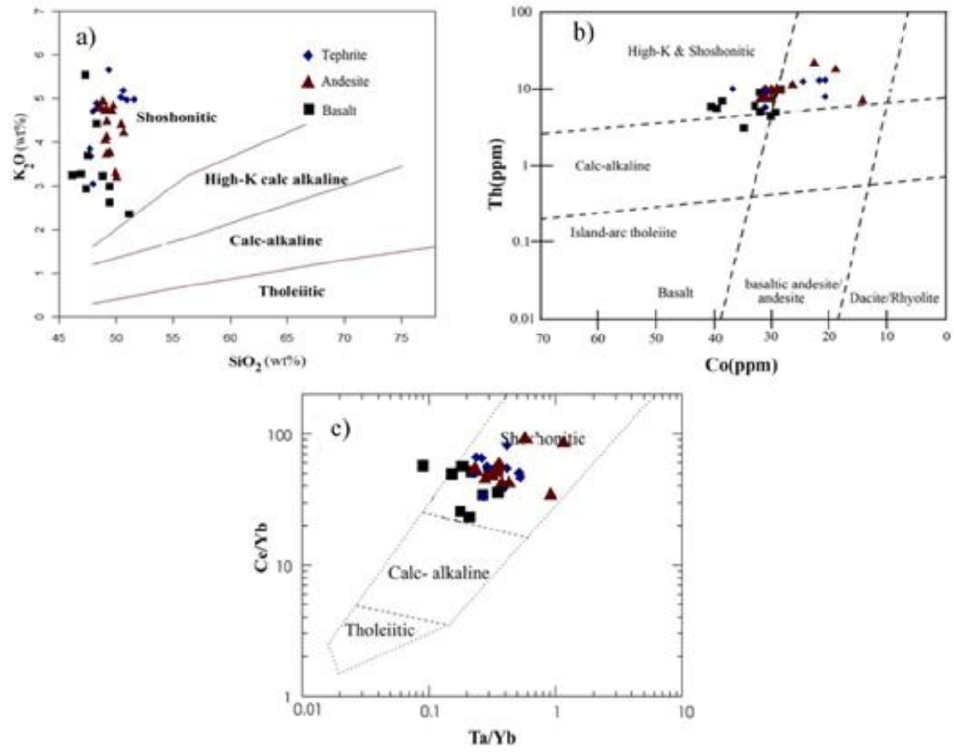
Figure 6. ( a ) SiO 2 versus K 2 O [6]. ( b ) Co versus Th [59]. ( c ) Ta/Yb versus Ce/Yb and